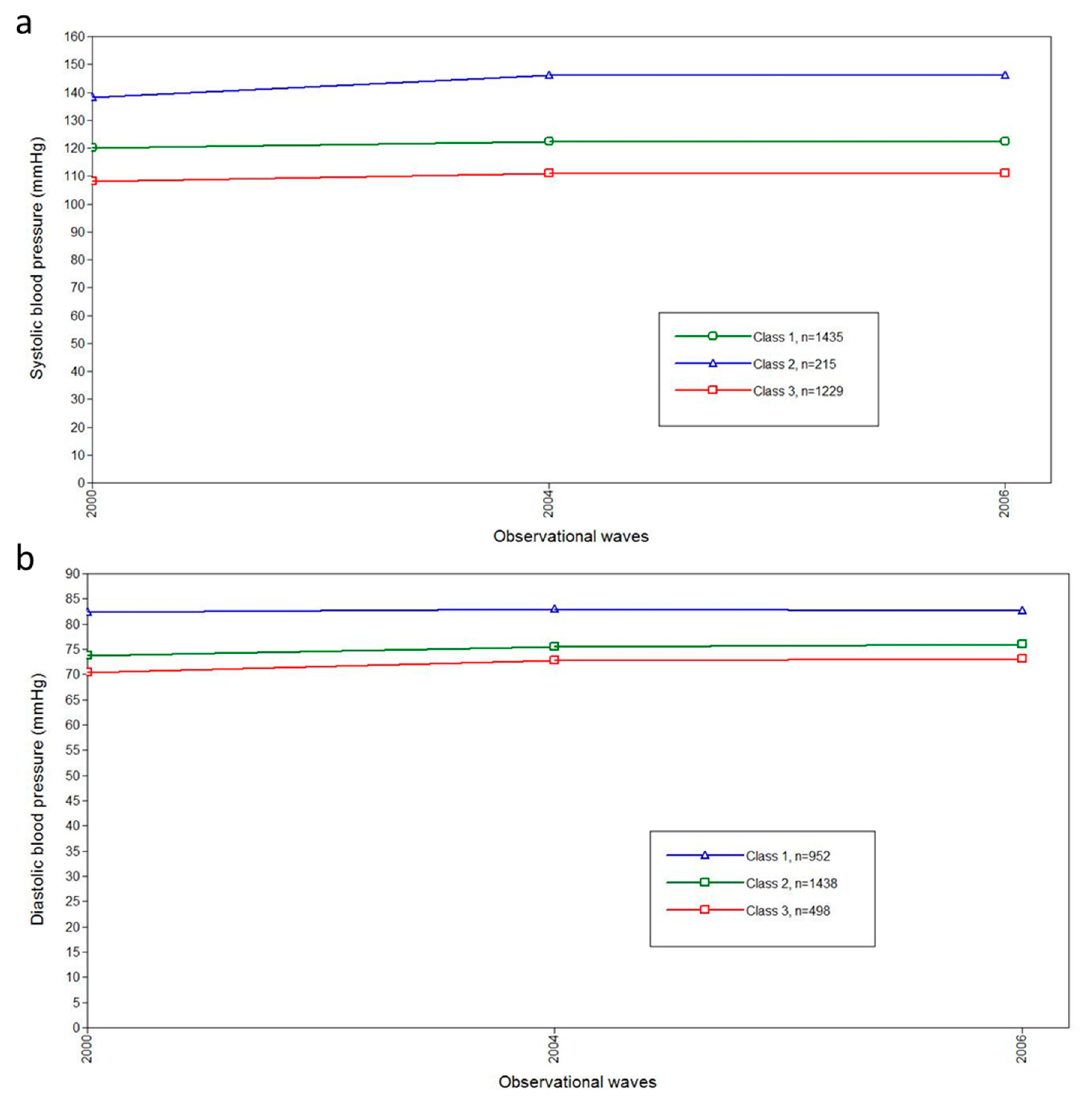
Figure 3. The blood pressure trajectories in the three-class model by GMM for myocardial infarction. ( a ) The plots for classifications of systolic blood pressure trajectories by GMM for myocardial infarction. ( b ) The plots for classifications of diastolic blood pressure by GMM for myocardial infarction. Abbreviations: mmHg, millimeter of mercury; GMM, growth mixture model.